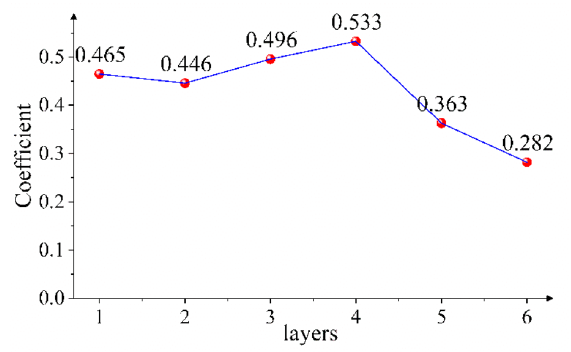
Figure 9. Coefficients of different decomposition layers of pollution signal.